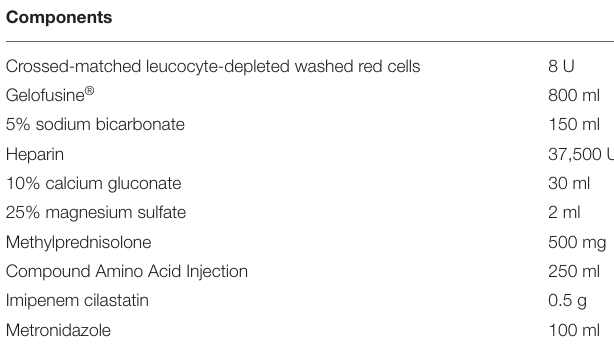
TABLE 1 | The components of the perfusate solution.